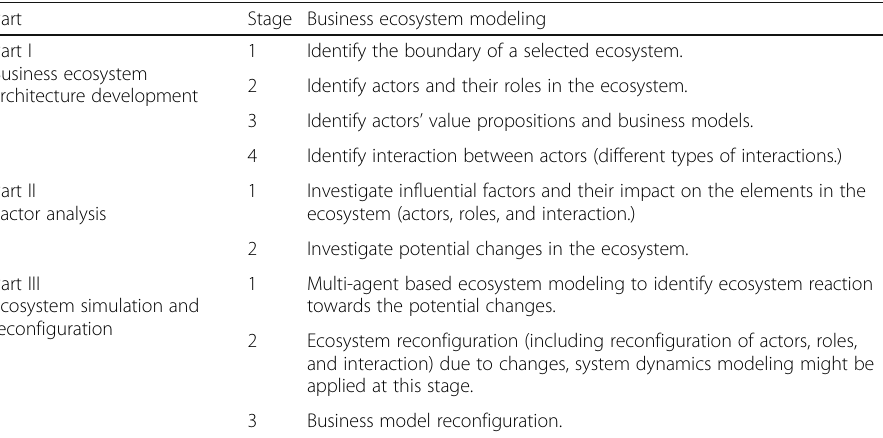
Table 12 The Framework and Steps of the Business Ecosystem Modeling Part Stage Business ecosystem modeling Part I Business ecosystem architecture